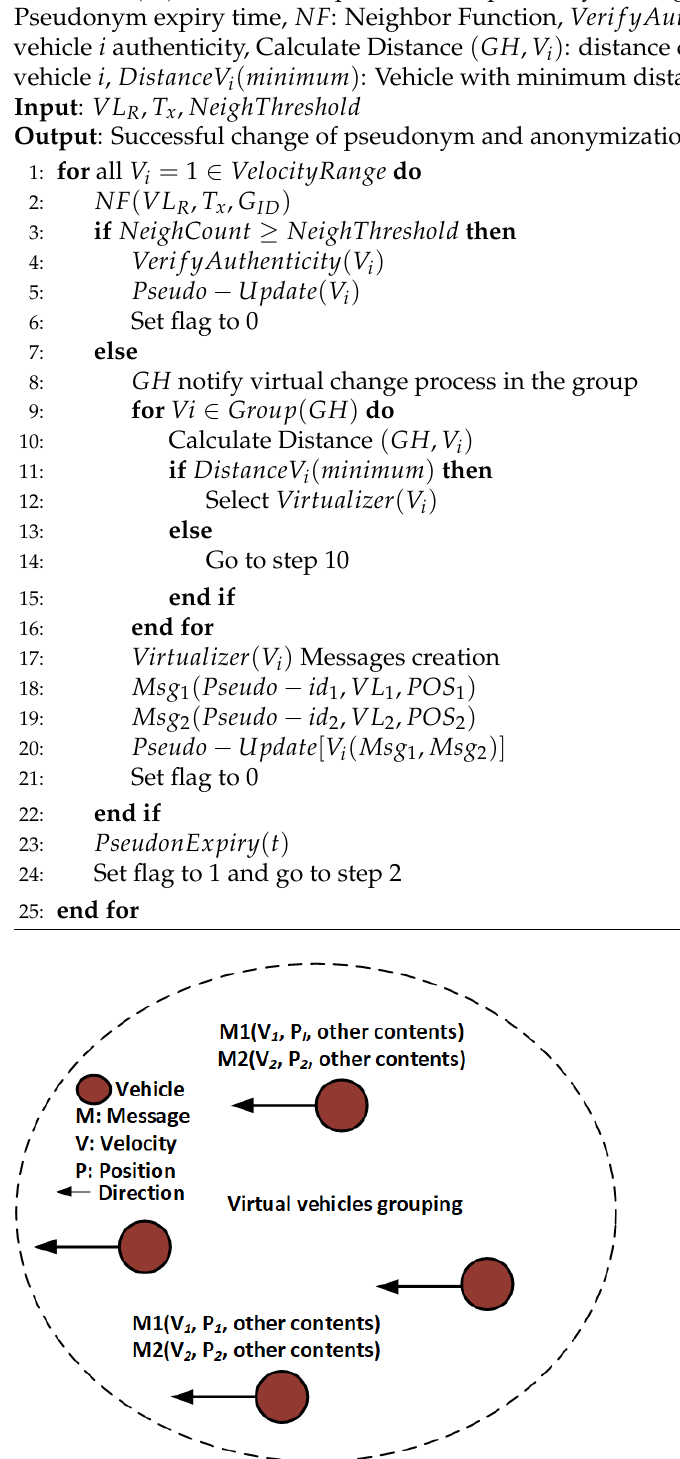
Figure 6. Virtual pseudonyms changing in the grouping